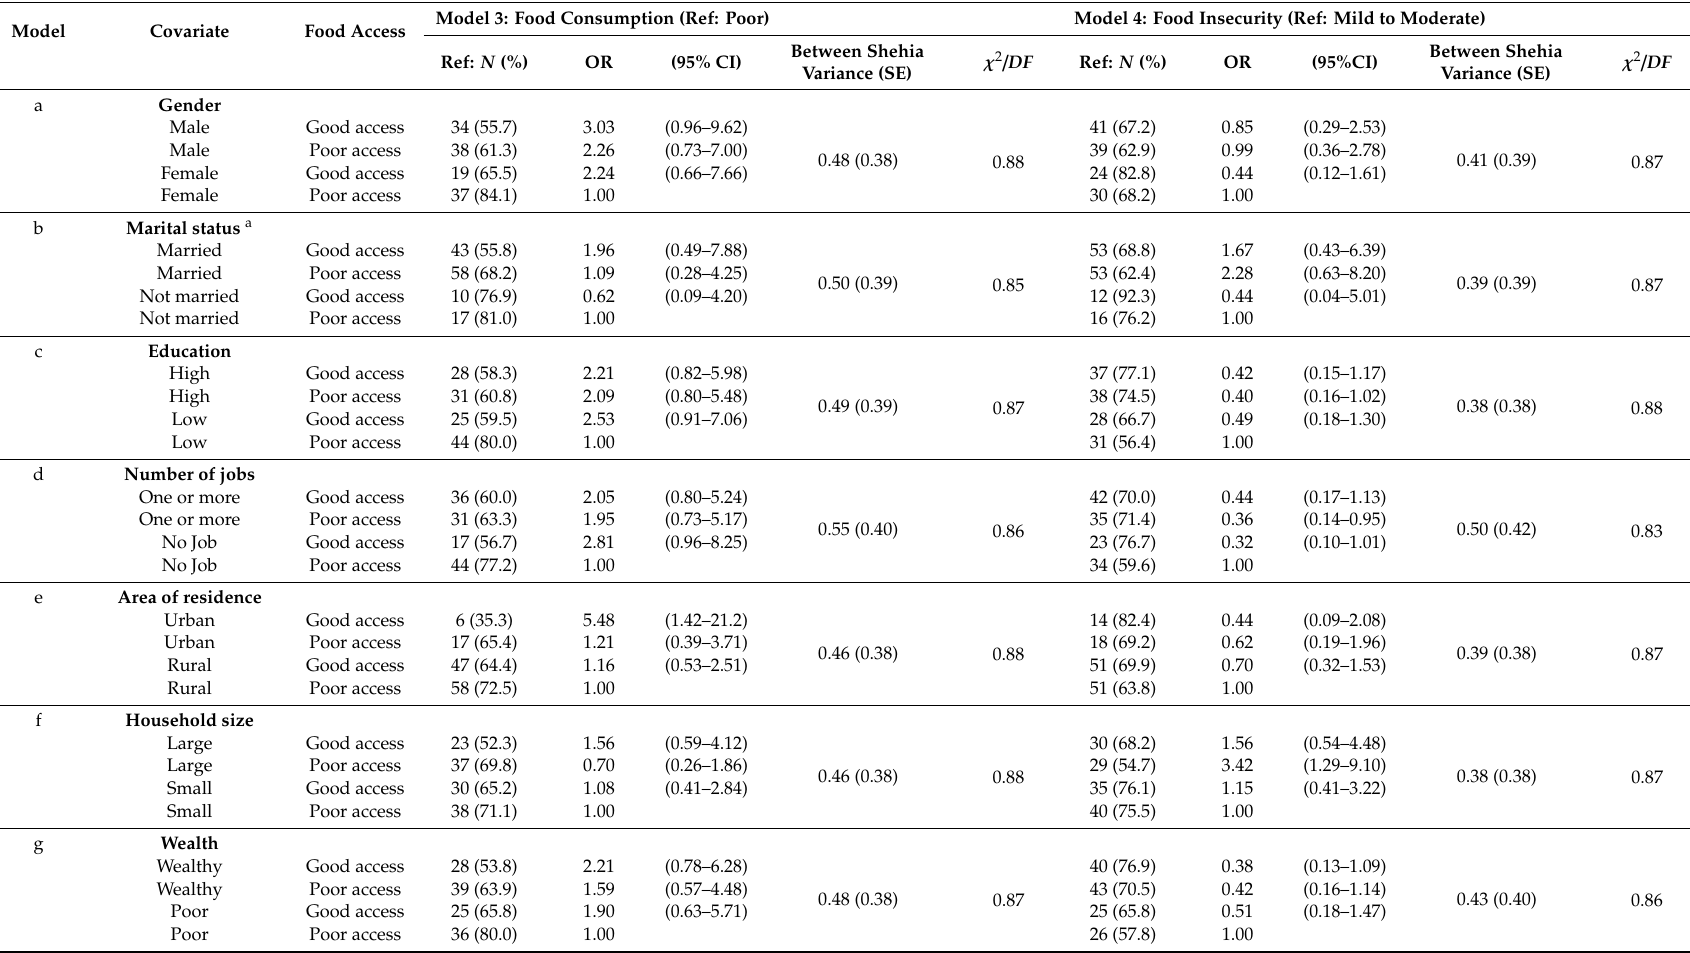
Table 5. Results of the multilevel logistic regressions in terms of odds ratios (OR) and 95% confidence limits as well as model fit (generalized chi-square / degrees of freedom) to investigate the interaction of food access with socioeconomic and demographic correlates on food consumption (Model 3a–h) and food insecurity (Model 4a–h), each adjusted for the remaining